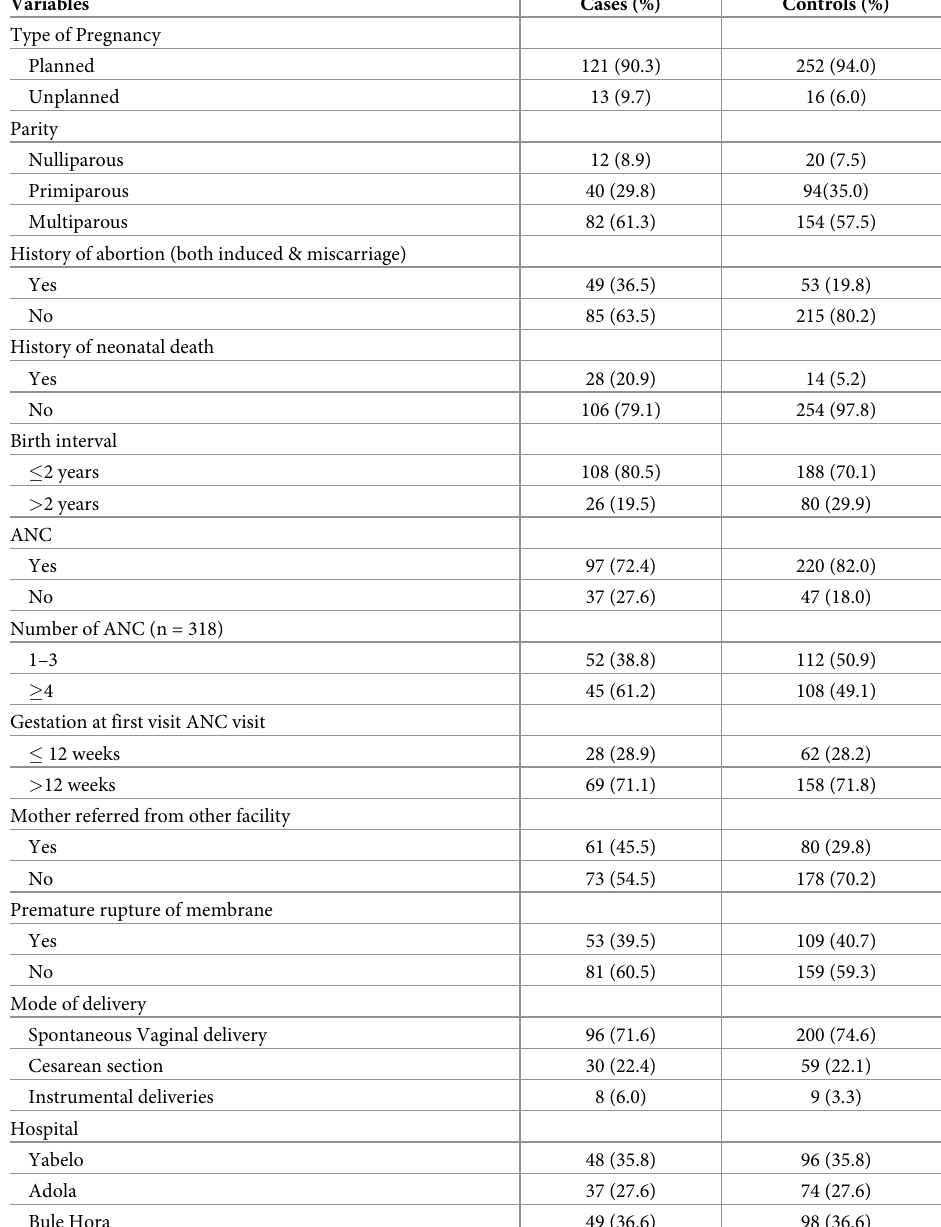
Table 2. Obstetric characteristics of mothers who gave live birth in Guji and Borena Zones selected Public Hospi- tals, Southern Ethiopia, 2021. Variables Cases (%) Controls (%) Type of